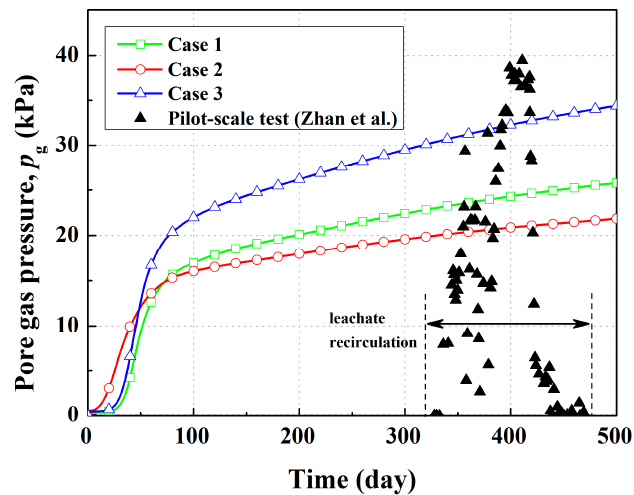
Figure 9. Validation of pore gas pressure calculation results.